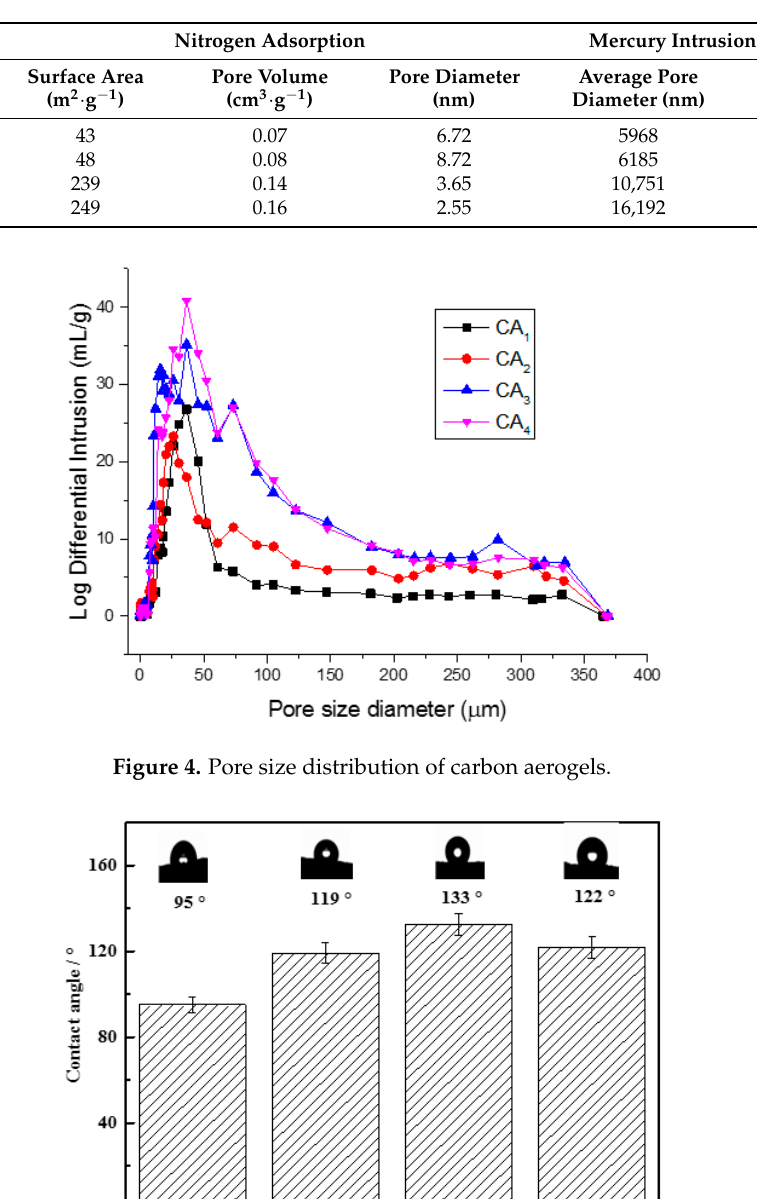
Table 1. Physical characteristics of carbon aerogels.